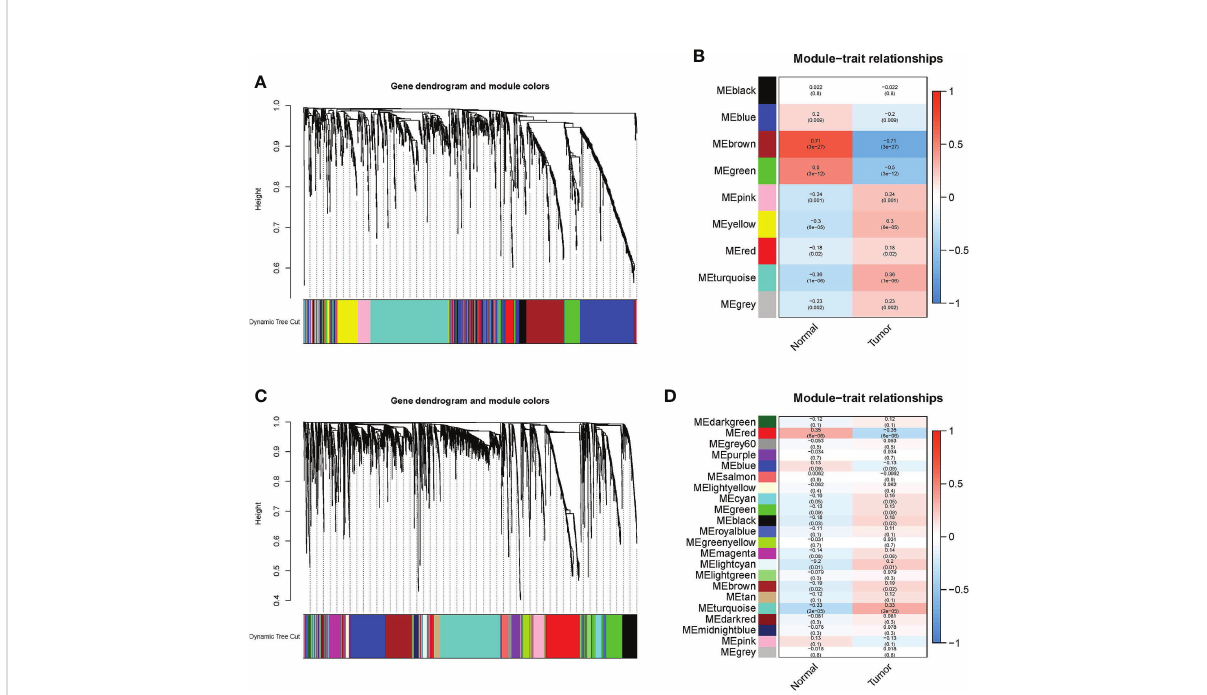
FIGURE 6 WGCNA was conducted to determine modules related to the clinical characteristics of EC. (A) In the EC module, hierarchical clustering dendrograms of determined lncRNAs are shown. (B) Correlations between Eigengenes of lncRNAs and clinical characteristics of EC in a heatmap. In each colored module, the association and p value are listed, and the MEbrown module with the highest correlation coef fi cient is selected. (C) In the EC module, hierarchical clustering dendrograms of determined mRNAs are shown. (D) Correlations between eigengenes of mRNAs and clinical characteristics of EC in a heatmap. In each colored module, the association and p value are listed, and the MEred module with the highest correlation coef fi cient is